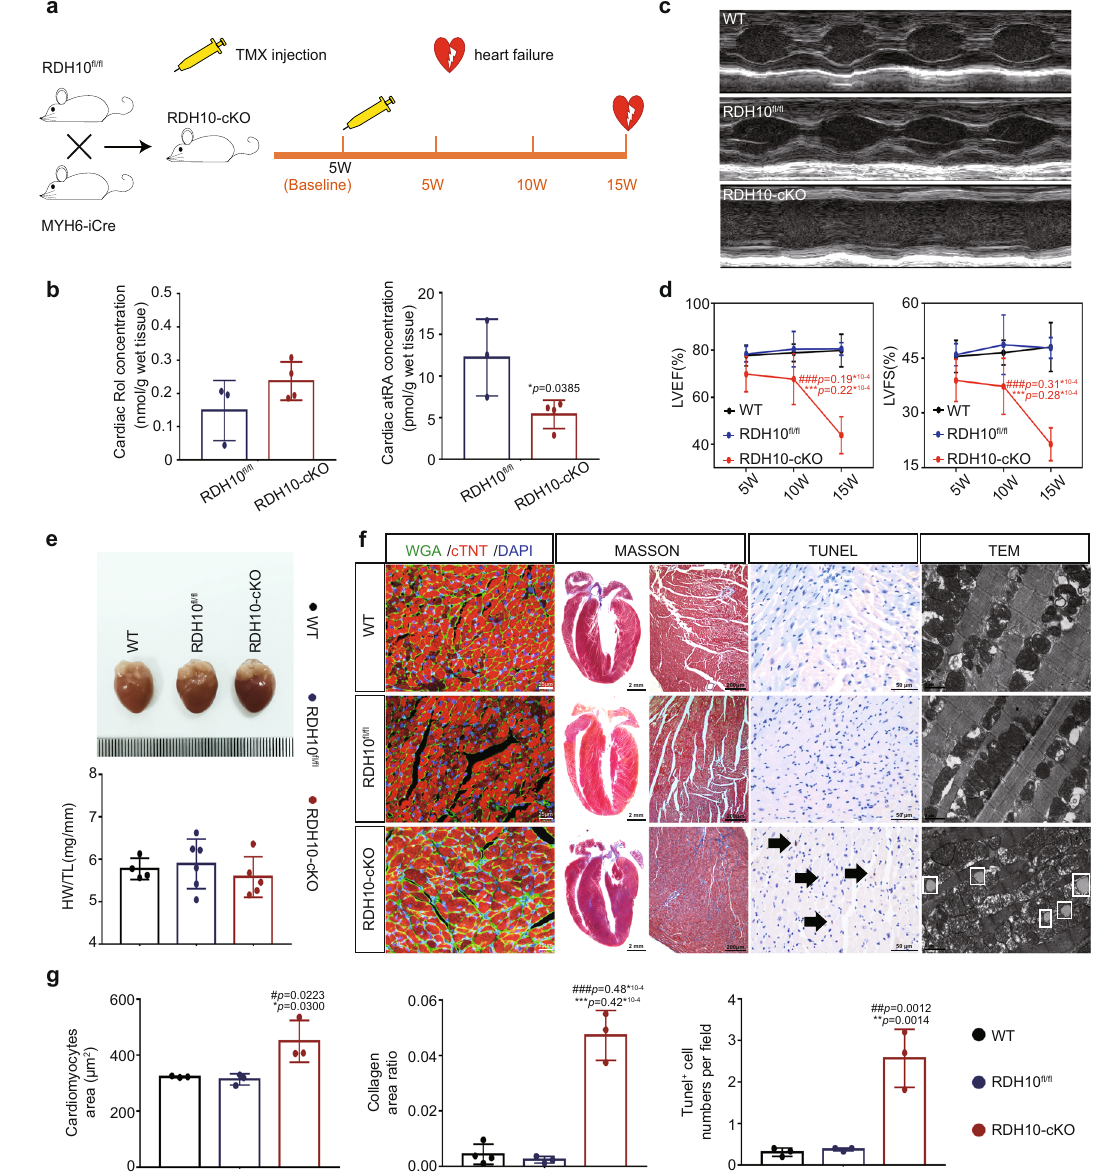
Fig. 4 | Cardiac retinol metabolic status, structure, and function in cardiomyocyte-speci fi c conditional Retinol Dehydrogenase 10-knockout (RDH10-cKO) mice (n means biologically independent animals). a Schematic diagram of the construction of RDH10-cKO mice. b Cardiac Rol and atRA levels, n =3(RDH10 fl / fl )and4(RDH10-cKO),* vs RDH10 fl / fl . c Echocardiography. d LVEFand LVFS, n (5w)=5(WT),4(RDH10 fl / fl ),5(RDH10-cKO); n (10w)=5(WT),3(RDH10 fl / fl ),7 (RDH10-cKO); n (15w)=4(WT),4(RDH10 fl / fl ),5(RDH10-cKO);* vs WT;# vs RDH10 fl / fl .